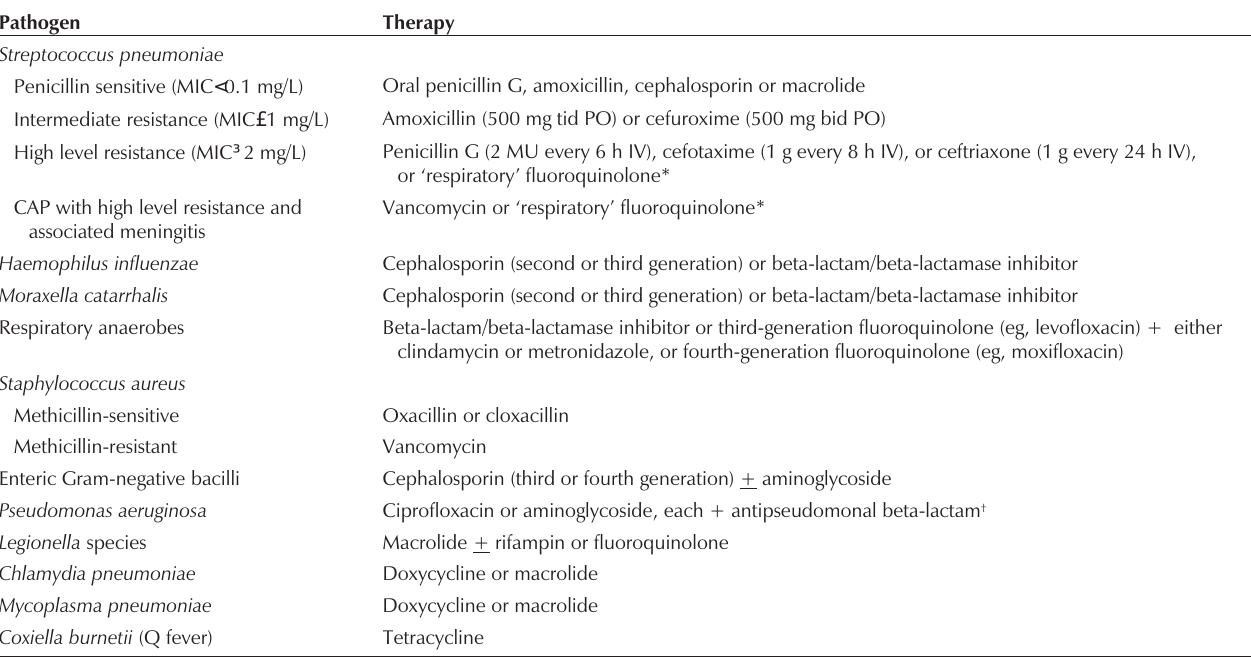
TABLE 6 Specific therapy for selected pathogens in community-acquired pneumonia (CAP) Pathogen Therapy Streptococcus